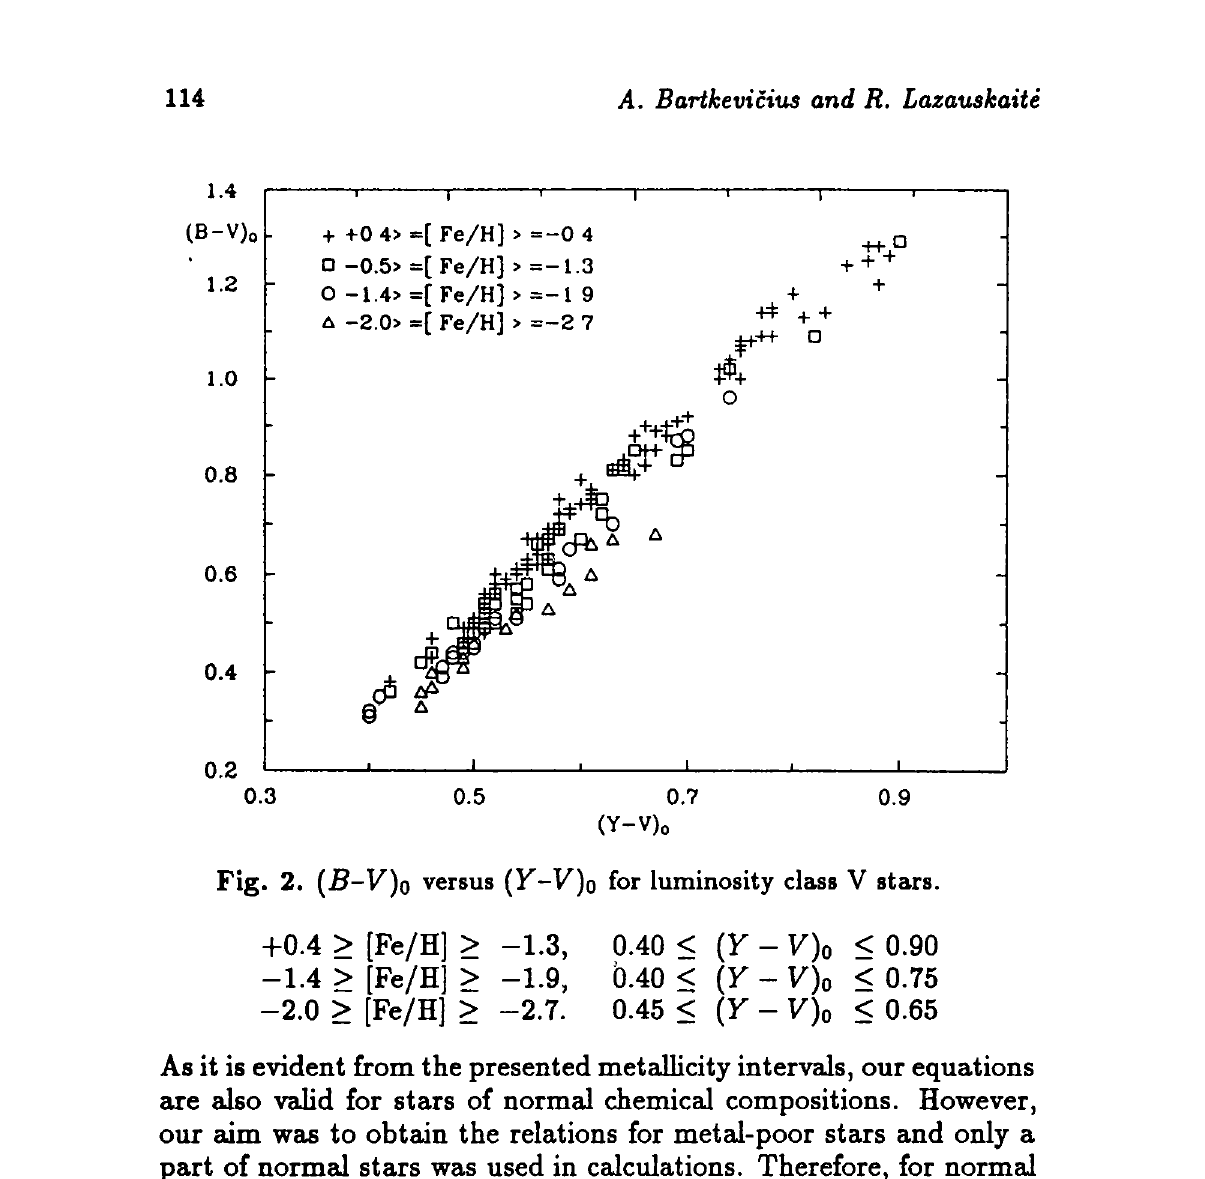
Fig. 2. ( B-V)o versus (F-KJo for luminosity class V